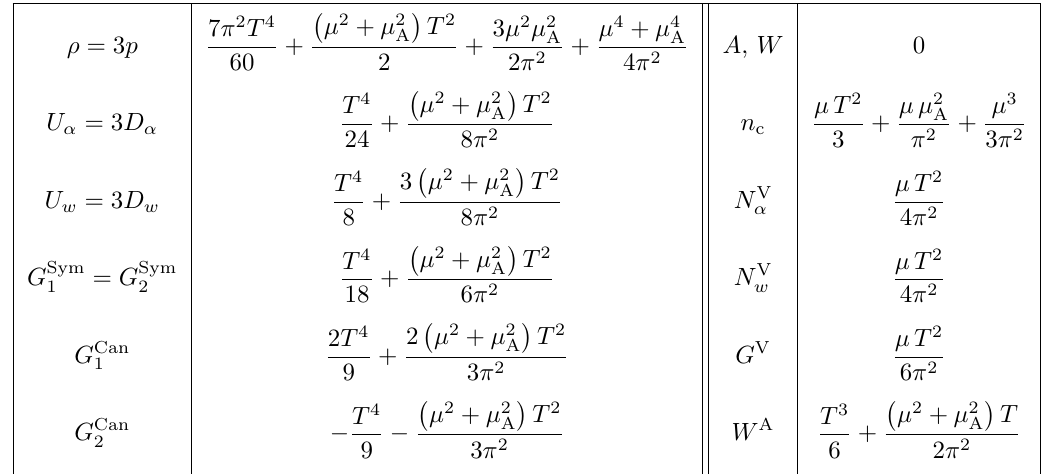
The non-chiral thermodynamic coefficients up to second order in thermal vortic- ity of the stress-energy tensor, electric and axial current for a free massless Dirac field (see eqs. (4.5), (4.9), (4.14) for definitions). Here we use T = 1 /